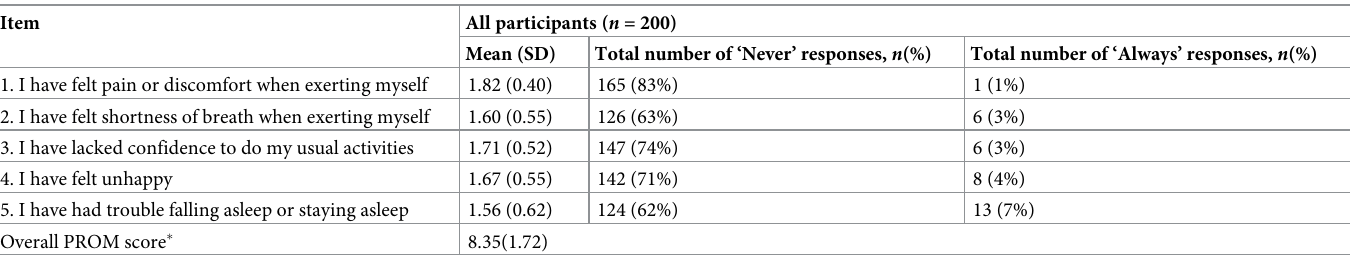
Table 4. Summary statistics for items included in the Monash University cardiac PROM (MC-PROM). Item